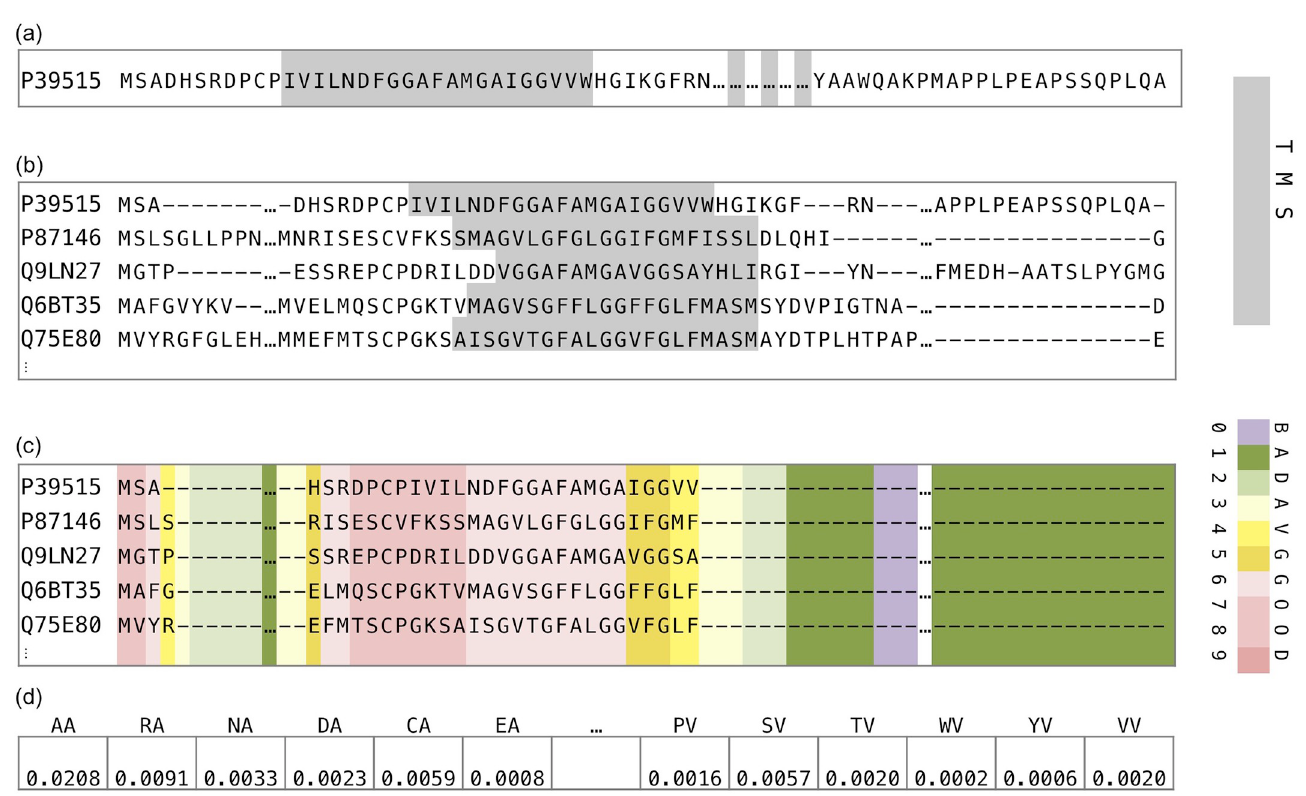
Fig 1. Example of steps of TranCEP. The figure illustrates the steps of TranCEP. Note that we abbreviated the middle section of the sequence. Part (a) shows the sequence the four TMSs in gray shading. Part (b) shows an MSA constructed by TM-Coffee. Gray shading indicates a TMS. Part (c) shows the color coding of the reliability index of each column as determined by TCS, and shows gaps in unreliable columns in the filtered MSA. Part (d) shows a 400-dimensional PAAC vector from the filtered